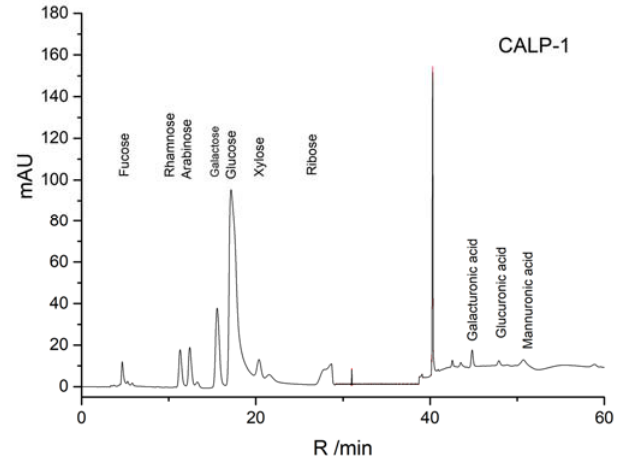
Figure 7. HPAEC profiles of CALP ‐ 1.